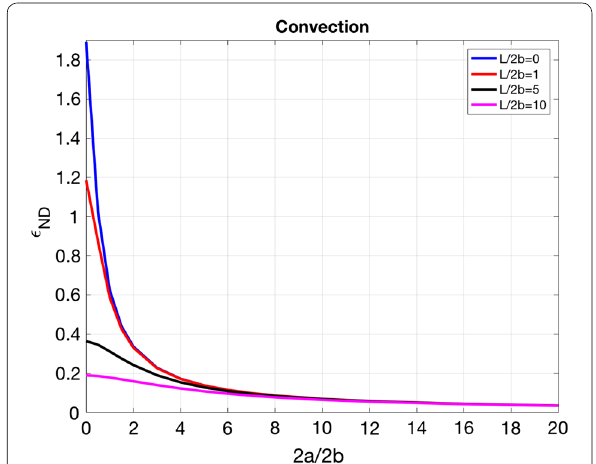
Fig. 6 Non-dimensional TKE dissipation rate plotted against 2 a/2b , for various values of L /2 b for C K these parameters